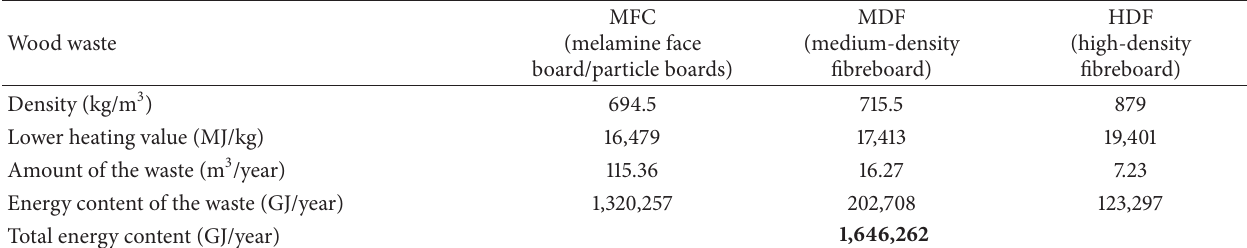
Table 5: Characteristics of wood waste generated in a furniture industry company [26].